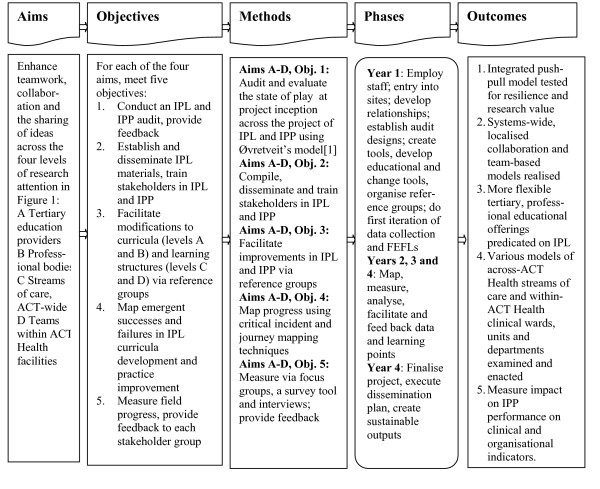
Research approach.